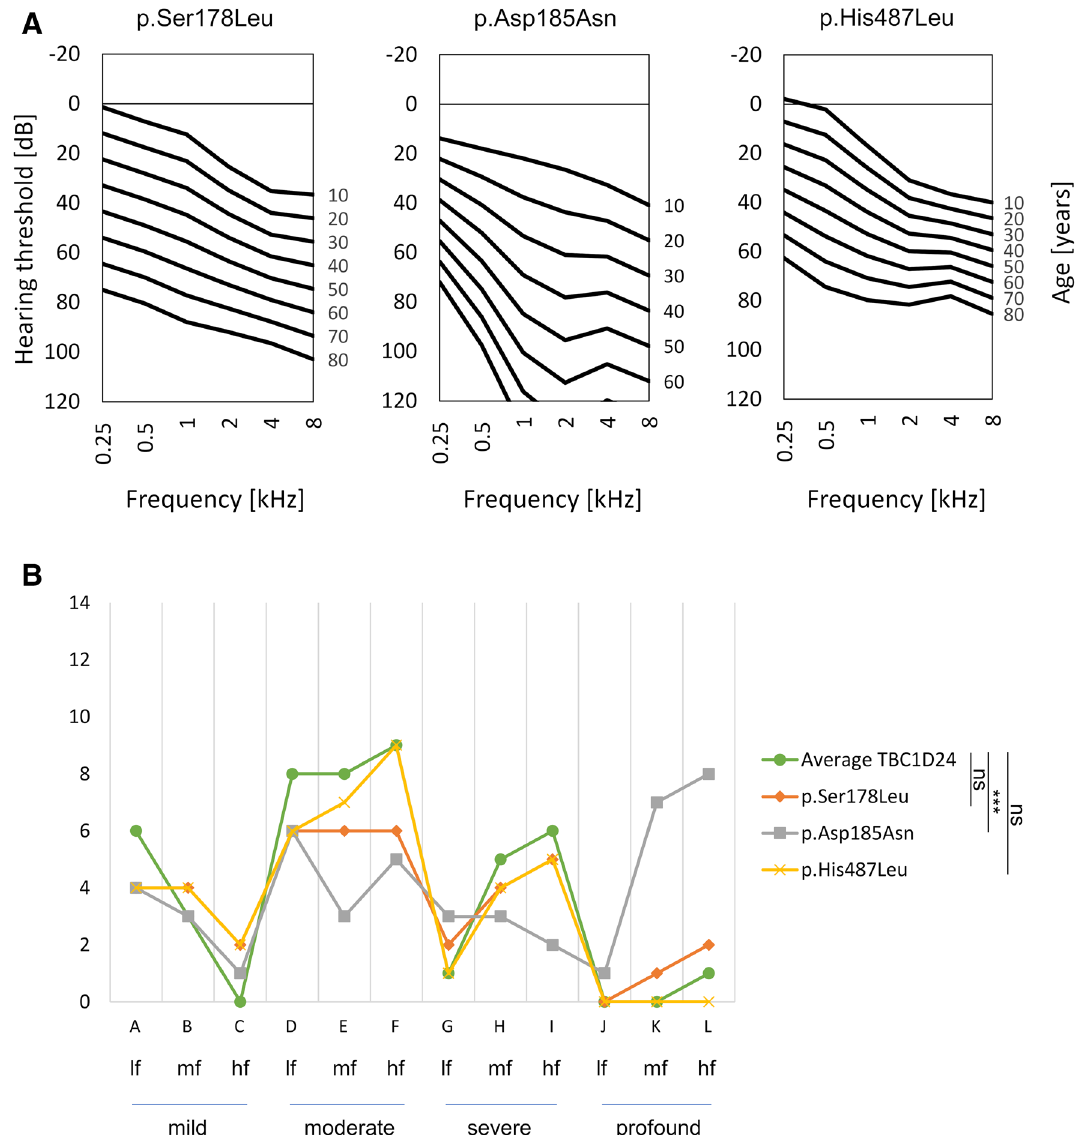
Figure 3. Audiological characteristics of HL observed in patients with a particular TBC1D24 pathogenic variant. ( A ) ARTA for patients with p.Ser178Leu, p.Asp185Asn and p.His487Leu pathogenic variants. ( B ) Threshold feature array for HL pattern observed for a particular TBC1D24 pathogenic variant. The graph represents the distribution of ARTA data points counted for different classes of HL degree and frequency (prepared based on the model proposed by Huygen et al. 2003) 19 . lf low frequencies, mf mid frequencies, hf high